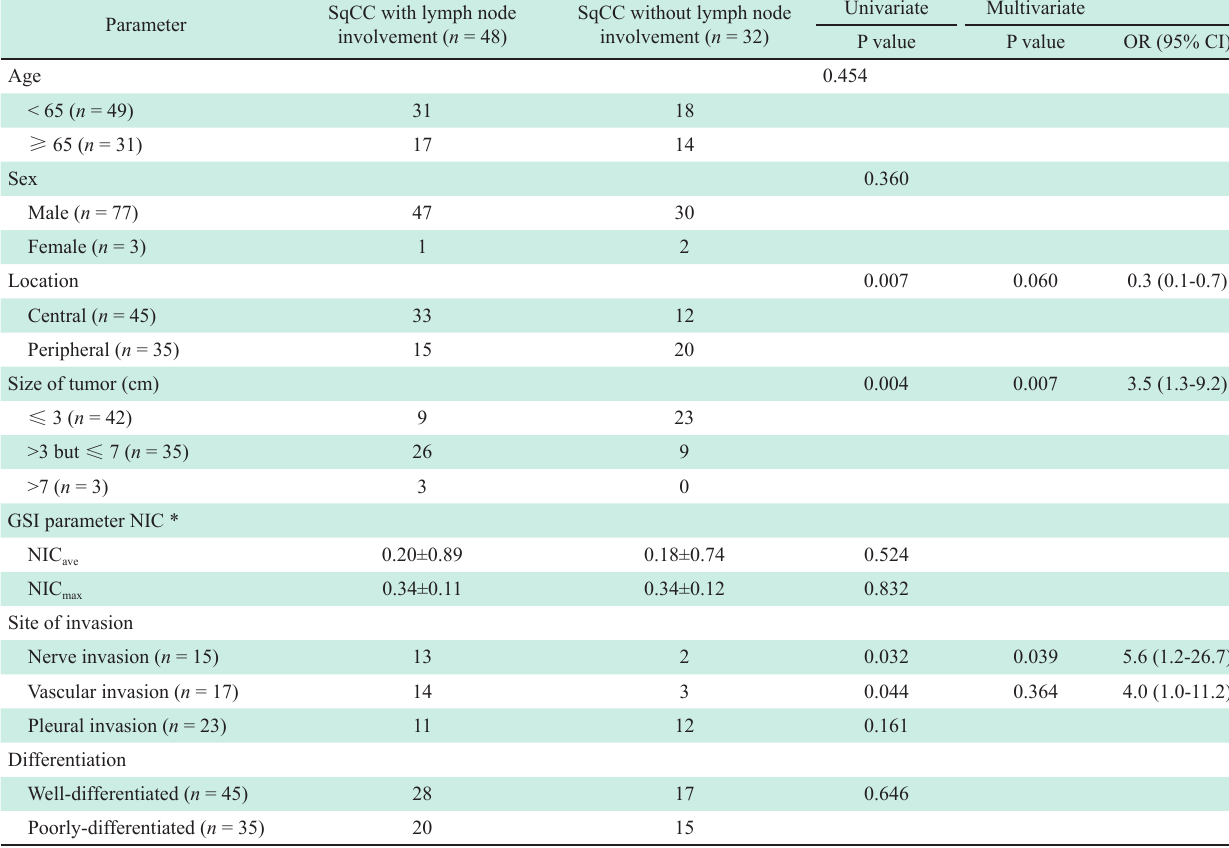
Table 3 Difference of clinicopathological characteristics between the patients diagnosed SqCC with and without lymph node involvement